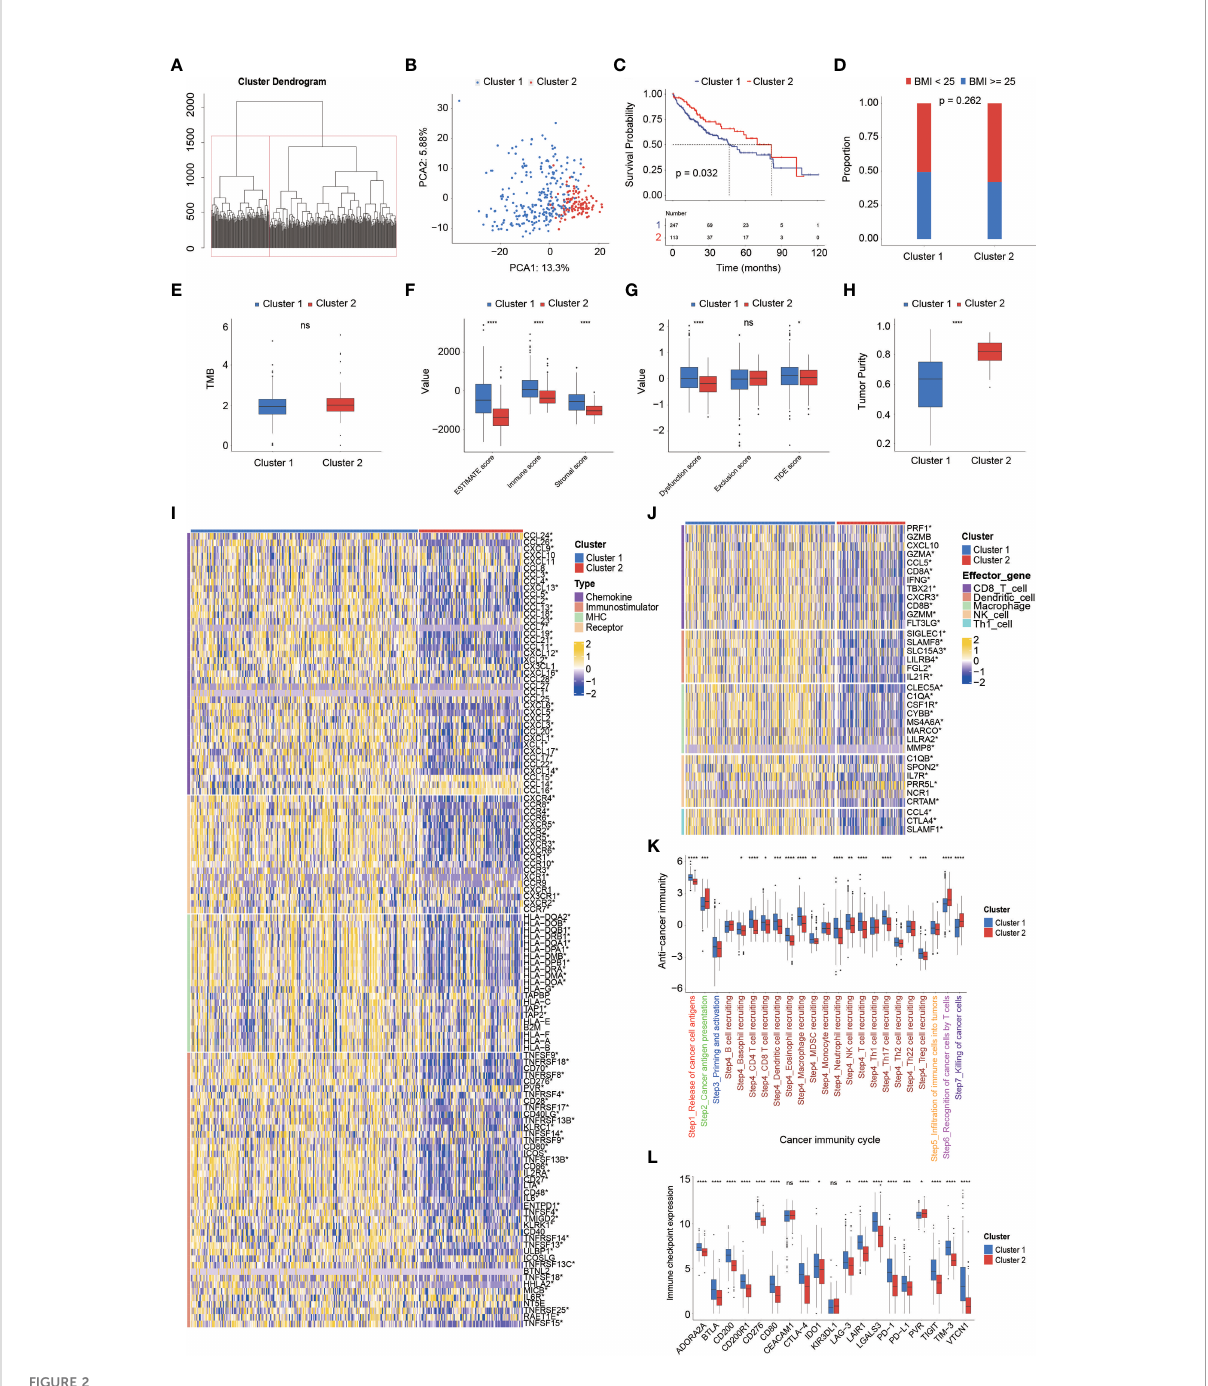
FIGURE 2 The overweight-associated transcriptome highly correlated with prognosis, immune characteristics, and anti-cancer immunity in TCGA-HCC cohort. (A) Unsupervised hierarchical clustering by foundation of overweight-associated transcriptome in TCGA-HCC cohort. (B) Principal component analysis for two clusters. (C) Kaplan – Meier curve analysis for two clusters. (D) Proportional analysis of patients with overweight/obesity between these two clusters. (E – H) Comparison of TMB level (E) , ESTIMATE score (F) , TIDE score (G) , and tumor purity (H) between clusters 1 and 2. (I) Differences in the expression of immunomodulators (chemokines, receptors, MHC molecules, and other immunomodulators) between clusters 1 and 2. (J) Evaluation of effector gene expression of tumor-in fi ltrating immune cells. (K) Comparison of cancer immunity cycles between clusters 1 and 2. (L) Comparison of immune inhibitory checkpoint expression between clusters 1 and 2. TMB, tumor mutational